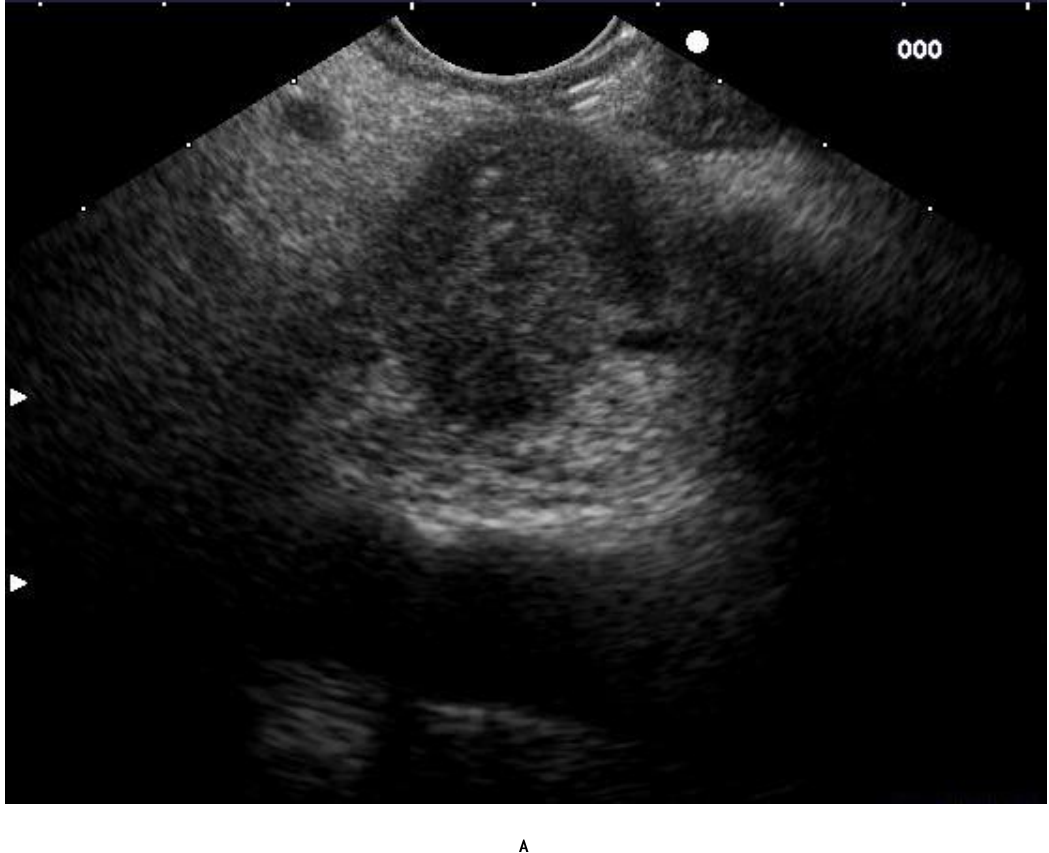
FIGURE 9 . (A) Renal metastasis of the head of pancreas; (B) enhancement of vascularization after sonovue